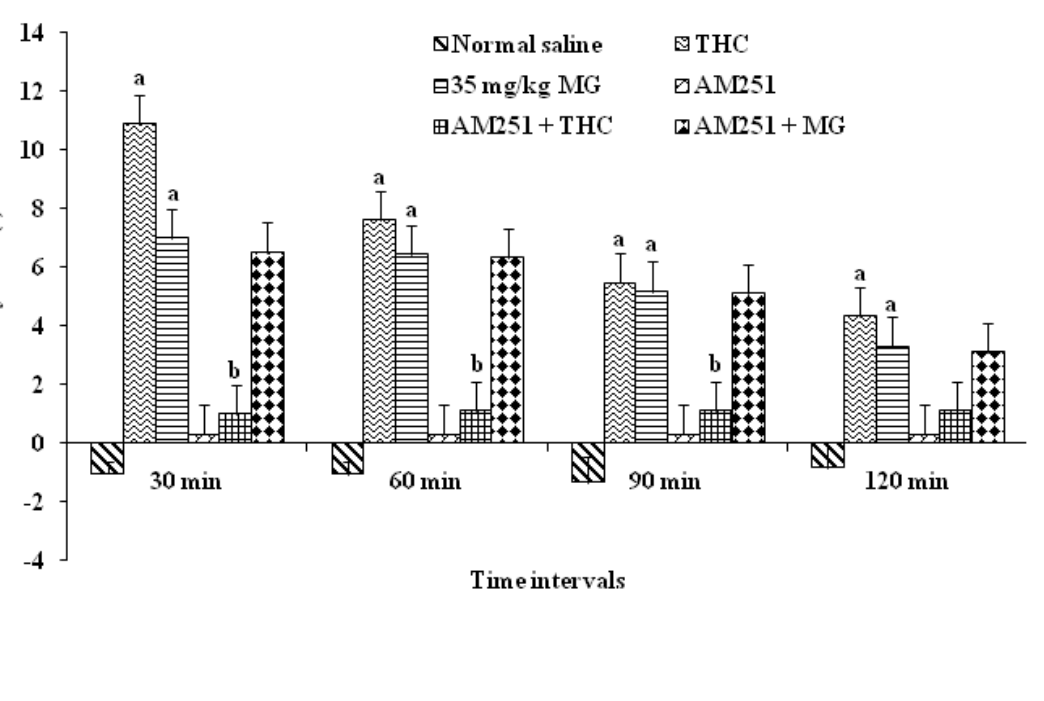
Figure 6. Effects of cannabinoid 1 receptor (CB1) antagonist AM251 on mitragynine-induced antinociception (35 mg/kg). Each column represents the mean ± SEM of latency time (s) of six animals in each group. Values are statistically significant at a p < 0.05 compared to normal saline (vehicle control) and b p < 0.05 compared to THC alone